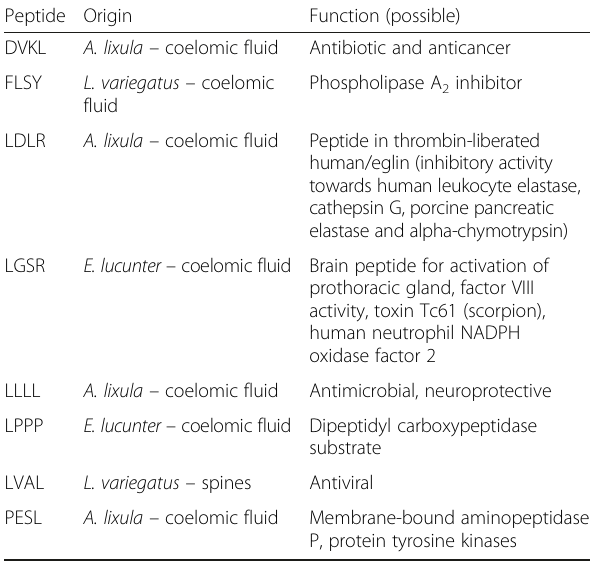
Table 3 Search of de novo sequenced peptides of sea urchins in